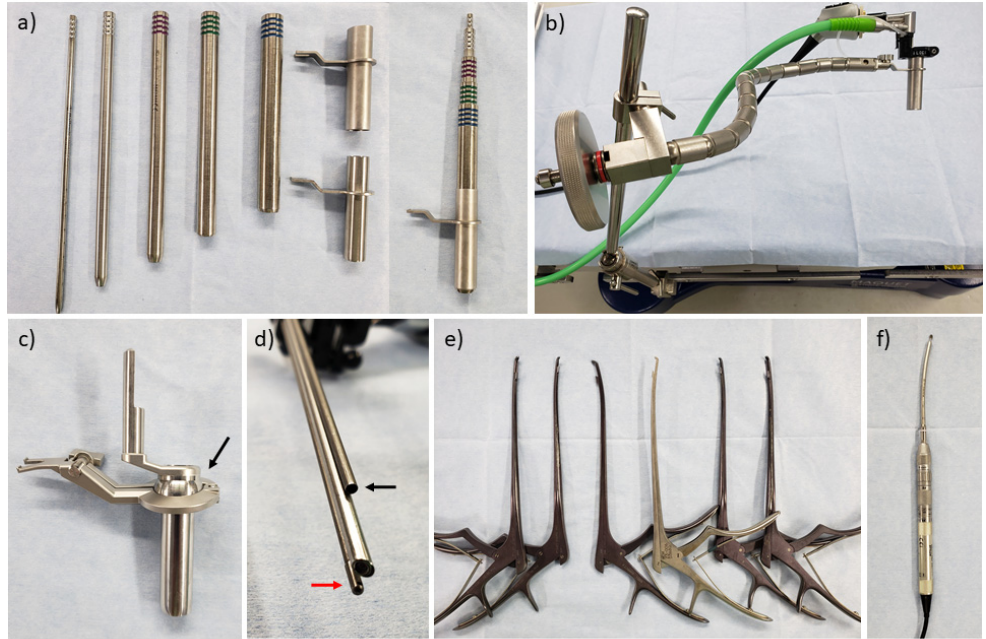
Figure 1. Surgical equipment for tubular microendoscopic decompression surgery. ( a ) Serial tubular dilator and retractor (METRx ® ). ( b ) Flexible arm assembly (METRx ® ). ( c ) Tubular retractor of the SYNCHA ® system. The black arrow indicates the ball link. ( d ) Scope attachment of the SYNCHA ® system. The black arrow indicates the nozzle for air suction, while the red arrow indicates the nozzle for the irrigation of the endoscope surface. ( e ) Variation of curved Kerrison rongeur. ( f ) Curved high-speed drill (Midas Rex ® ).